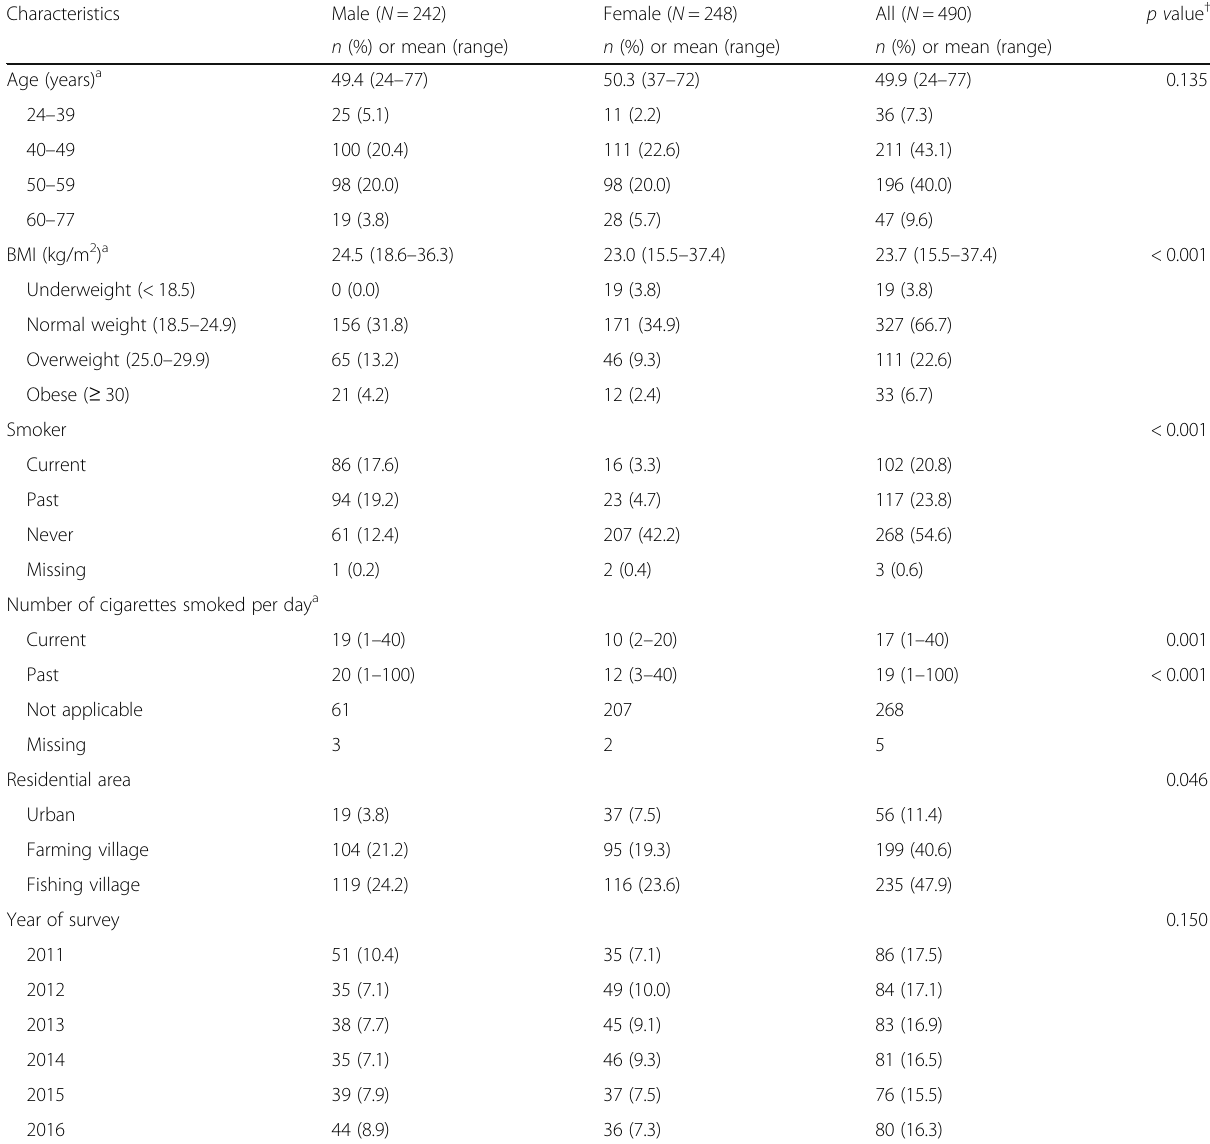
Table 1 Characteristics of 490 participants in SEDOCCH 2011 – 2016